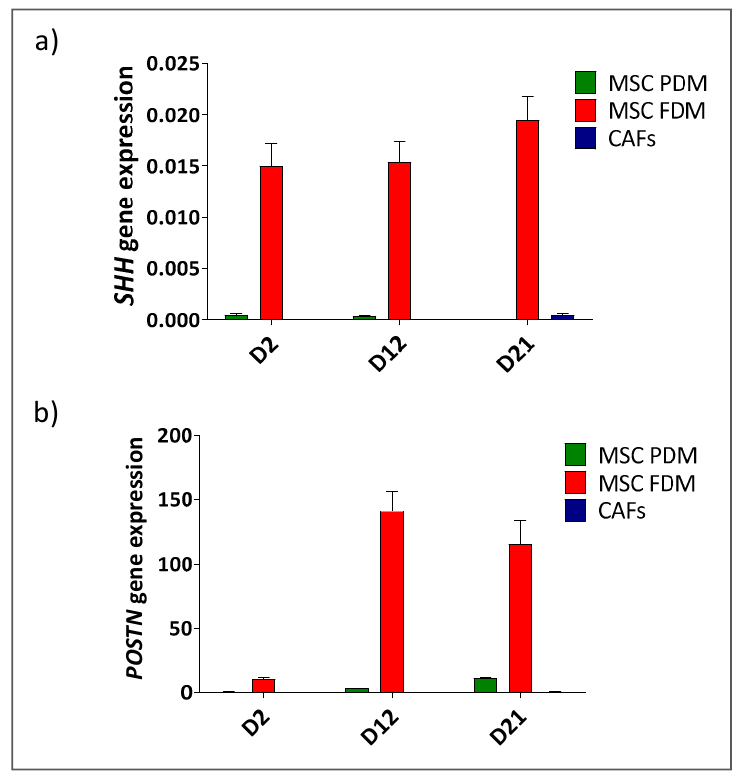
Figure A2. Vimentin expression in human pancreatic primary tissues. Example images of IHC analysis of vimentin protein expression in: ( a ) normal pancreatic human tissues, ( b ) moderately di ff erentiated pancreatic tumour and ( c ) poorly di ff erentiated pancreatic human tumour, ( d ) Negative control demonstrating absence of staining in PDT tissue when an isotype control antibody was substituted for the specific antibody to the target.